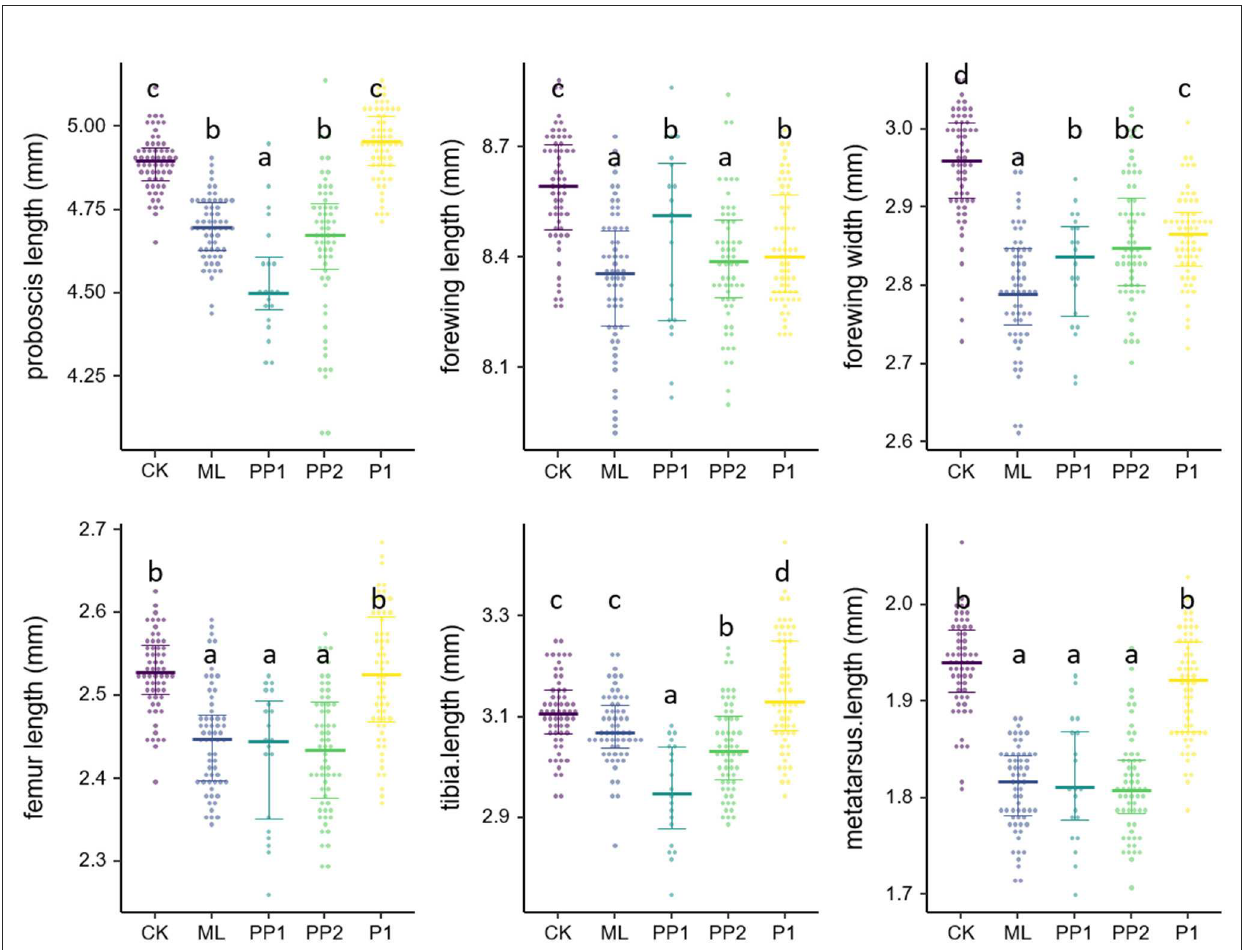
FIGURE4 Wing size and appendage size of honeybee broods exposed to 40 ◦ C for 16h. Colored dots represent experiment groups: CK, control group. ML, mature larva; PP1, the first day of prepupa; PP2, the second day of prepupa; P1, the first day of the pupa. Crossbars with whiskers in each group indicate the median value and the 25th and 75th